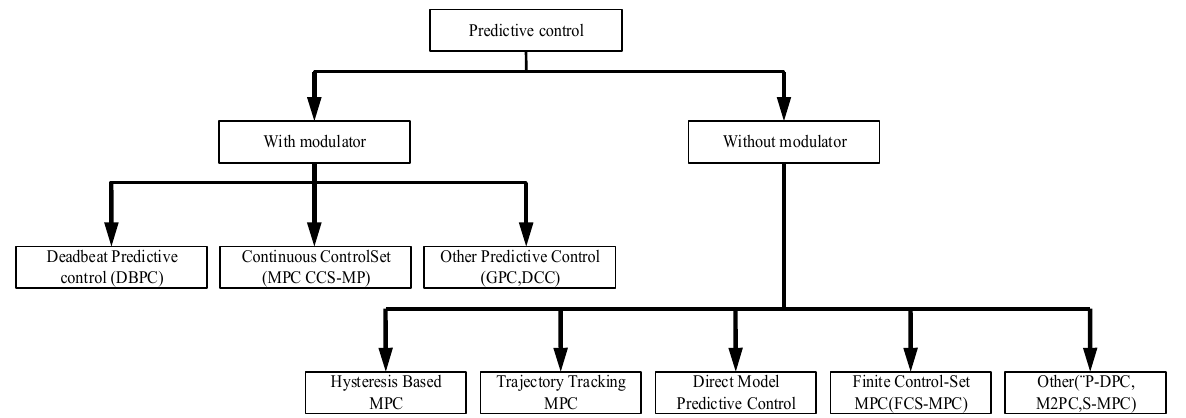
Figure 12. Classification of the different predictive control strategies.